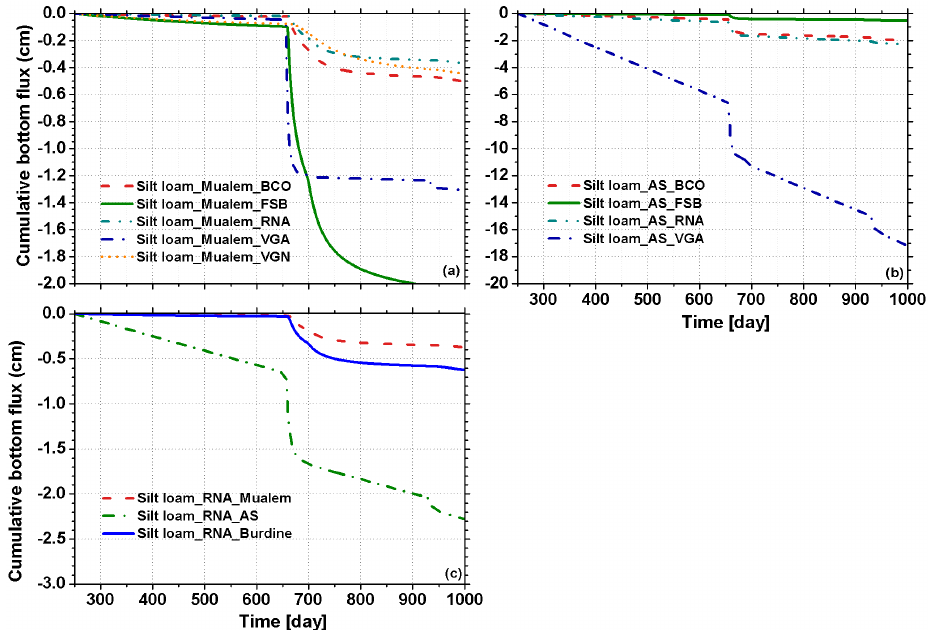
Figure 13. Cumulative bottom fluxes from a silt loam profile for all combinations of parameterizations (see Table 1) and Mualem’s (1976) (a) and Alexander and Skaggs’ (1986) conductivity functions (b) , and for the RNA parameterization with all three conduc- tivity functions (c) .